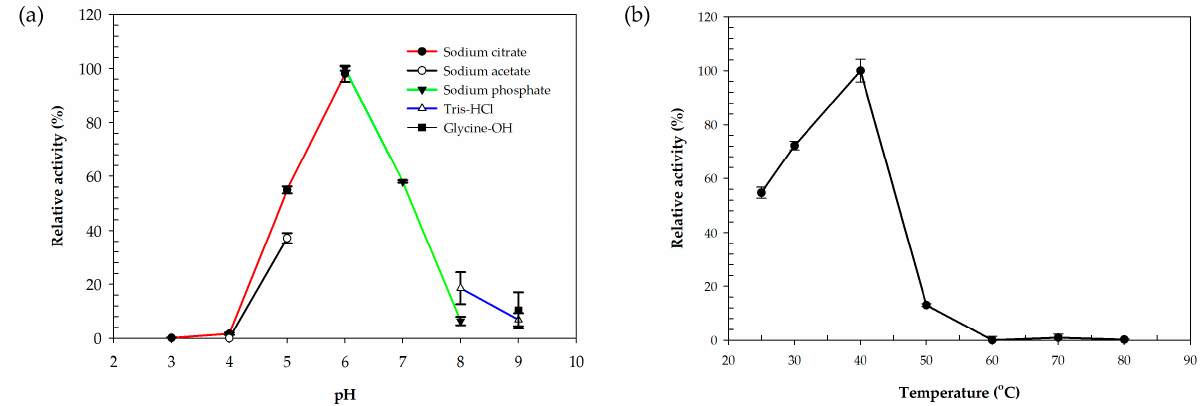
Figure 3. The effect of temperature and pH on pullulanase activity. ( a ) The influence of pH was measured in various buffers ranging from pH 3.0–9.0. ( b ) The influent of temperature on pullulanase activity was determined at temperatures ranging 25–80 ◦